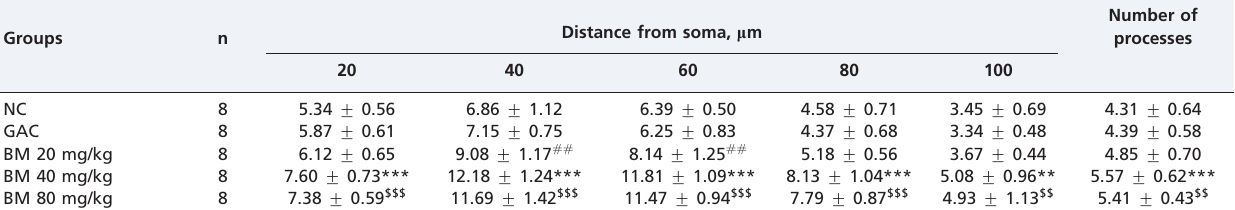
Table 3 - Basolateral amygdaloid neuronal dendritic intersections and the number of dendritic processes arising from the somata (6-week